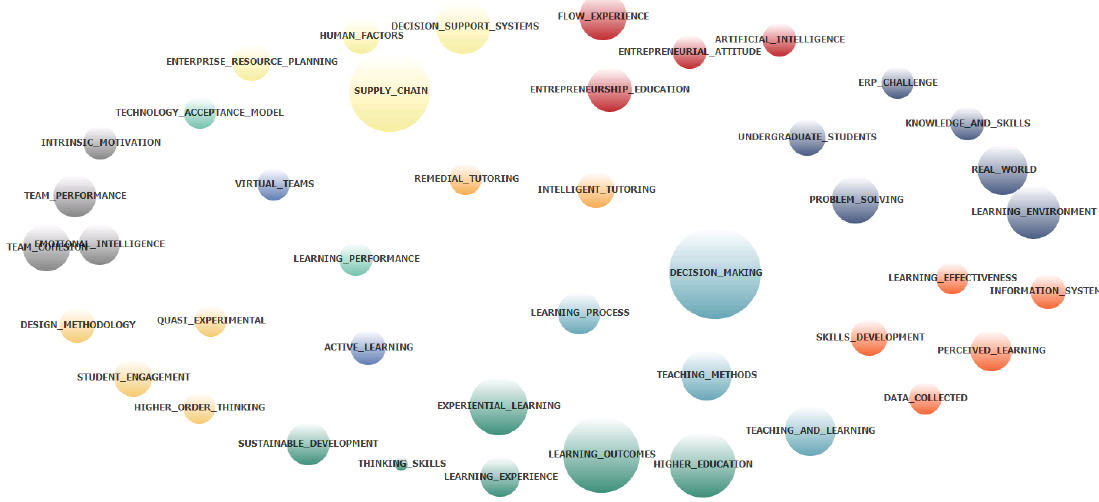
Figure 13. Mapping of clusters; Source: Authors’ work based on Scopus.